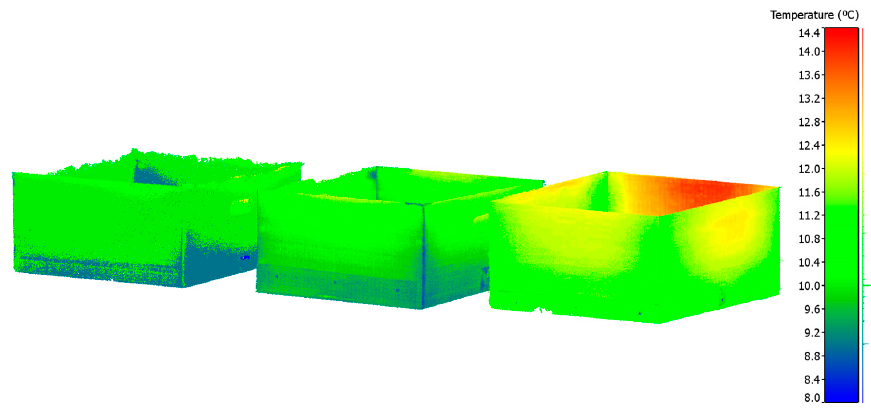
Figure 9. Segmentation of the hives: Surfaces to be evaluated of the three hives for their population assessment. Very low level of population ( Left ). Mid level of population ( Middle ). High level of population ( Right ).